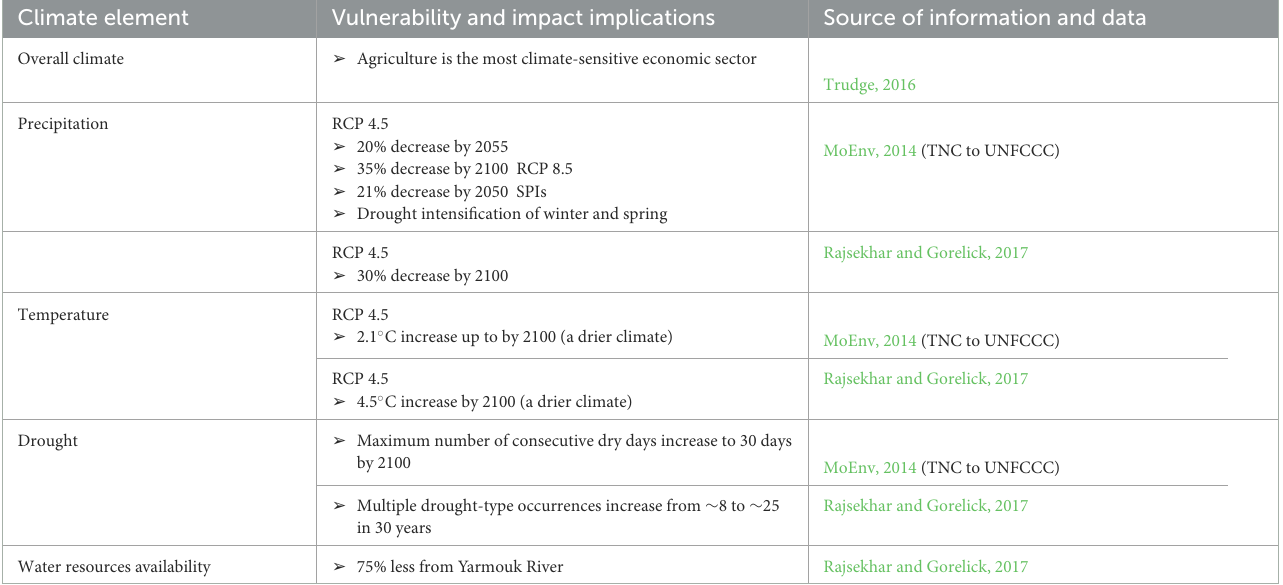
TABLE 1 Summary of the elements of climate change vulnerability and impact implications provided as messages to participants resulting from desk study and the analysis of available